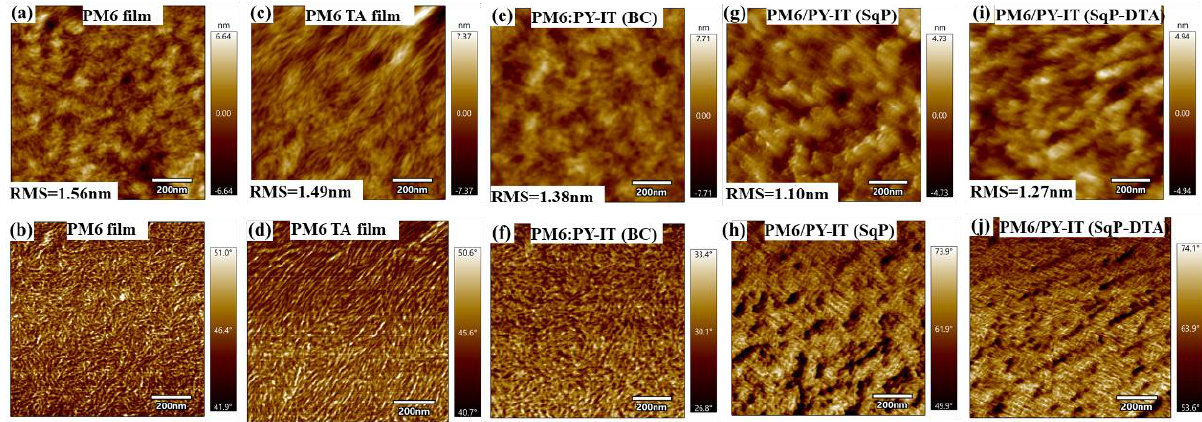
Figure 6. AFM height (top) and phase images (bottom) of ( a , b ) PM6 film, ( c , d ) thermally annealed PM6 film, ( e , f ) PM6:PY ‐ IT (BC), ( g , h ) PM6/PY ‐ IT (SqP), and ( i , j ) PM6/PY ‐ IT (SqP ‐ DTA).